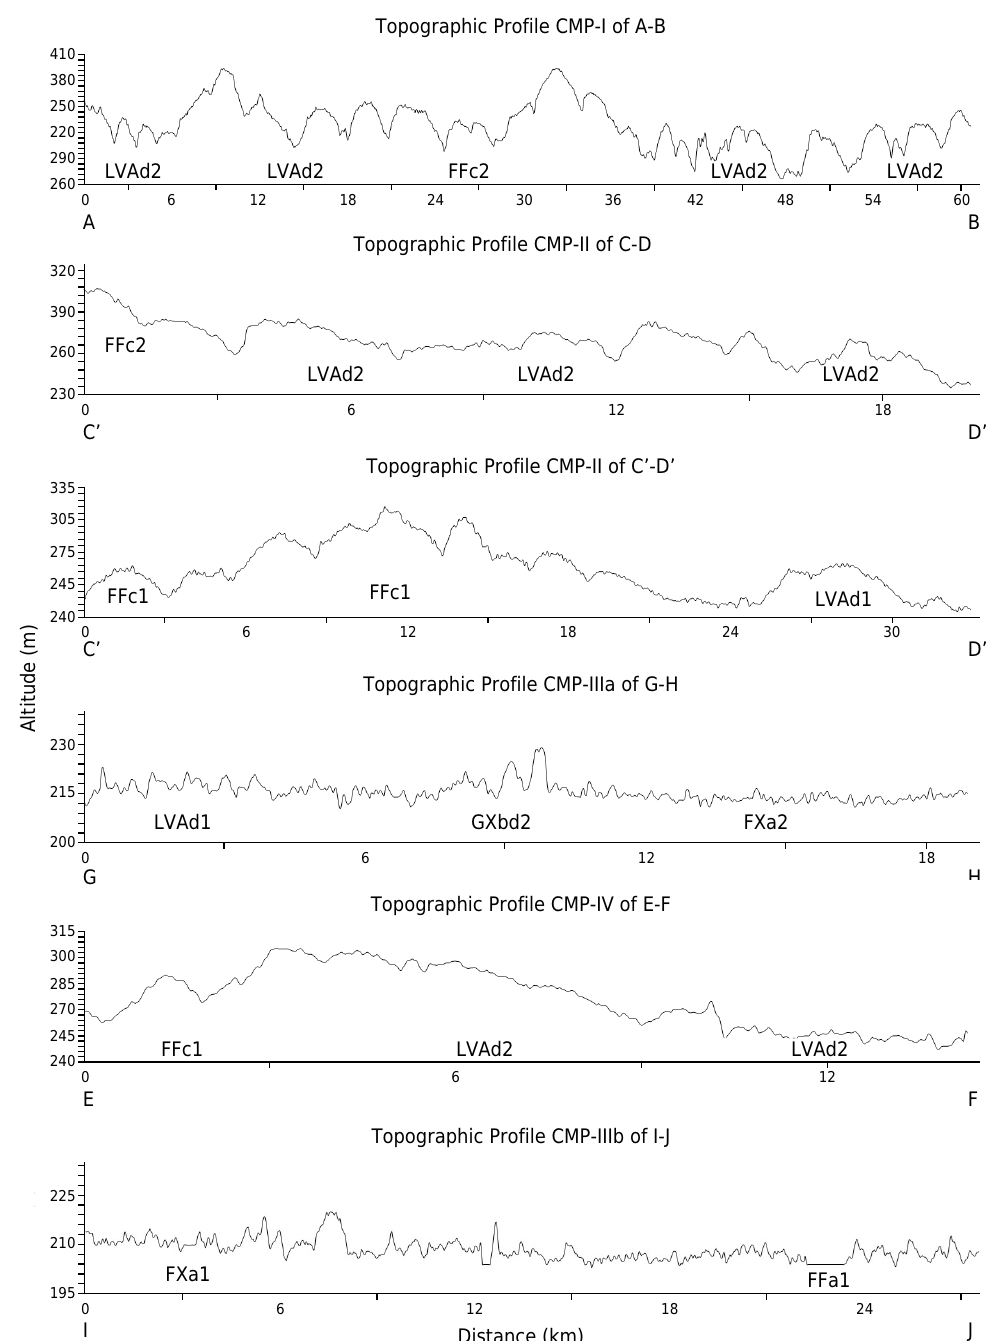
Figure 6. Representative topographic profiles with soil sequences from the municipality of São Miguel do Araguaia, state of Goiás,